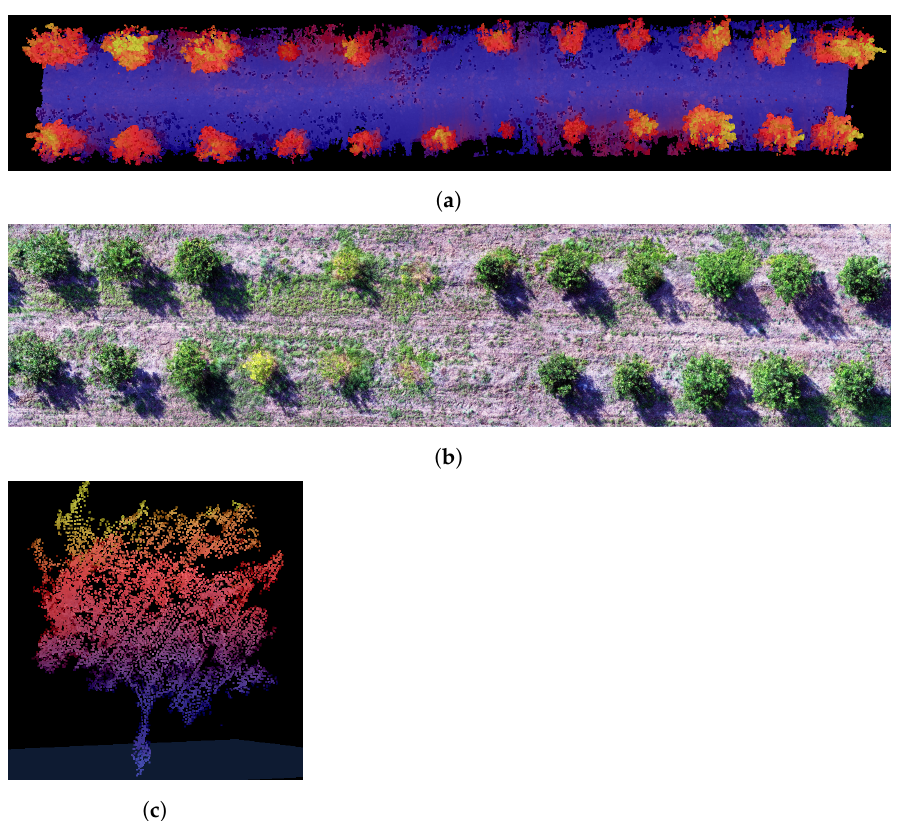
Figure 11. Obtained point cloud from the citrus crop segment: ( a ) Top view of the point cloud,